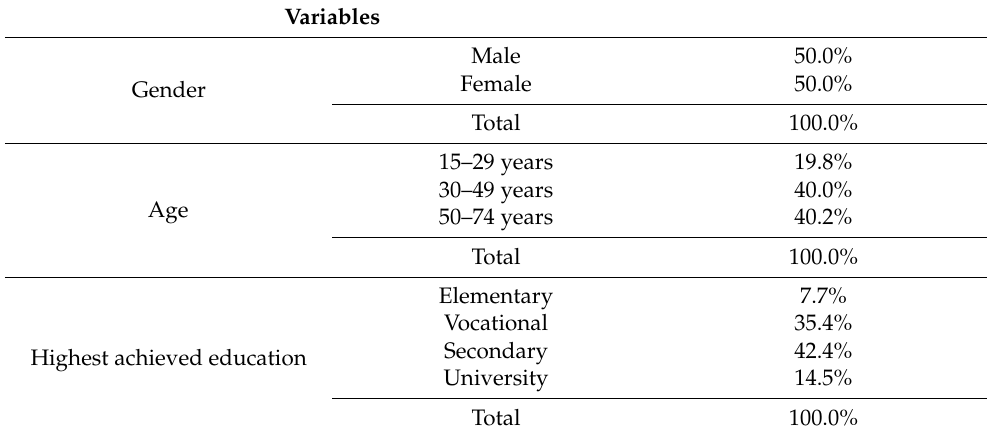
Table 1. Selected socio-demographic characteristics of the